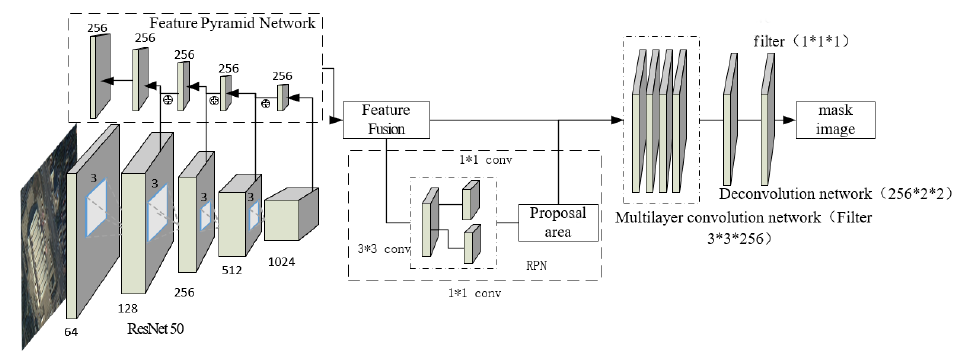
Figure 4. Single class extraction model of the convolution network based on Mask R-CNN.